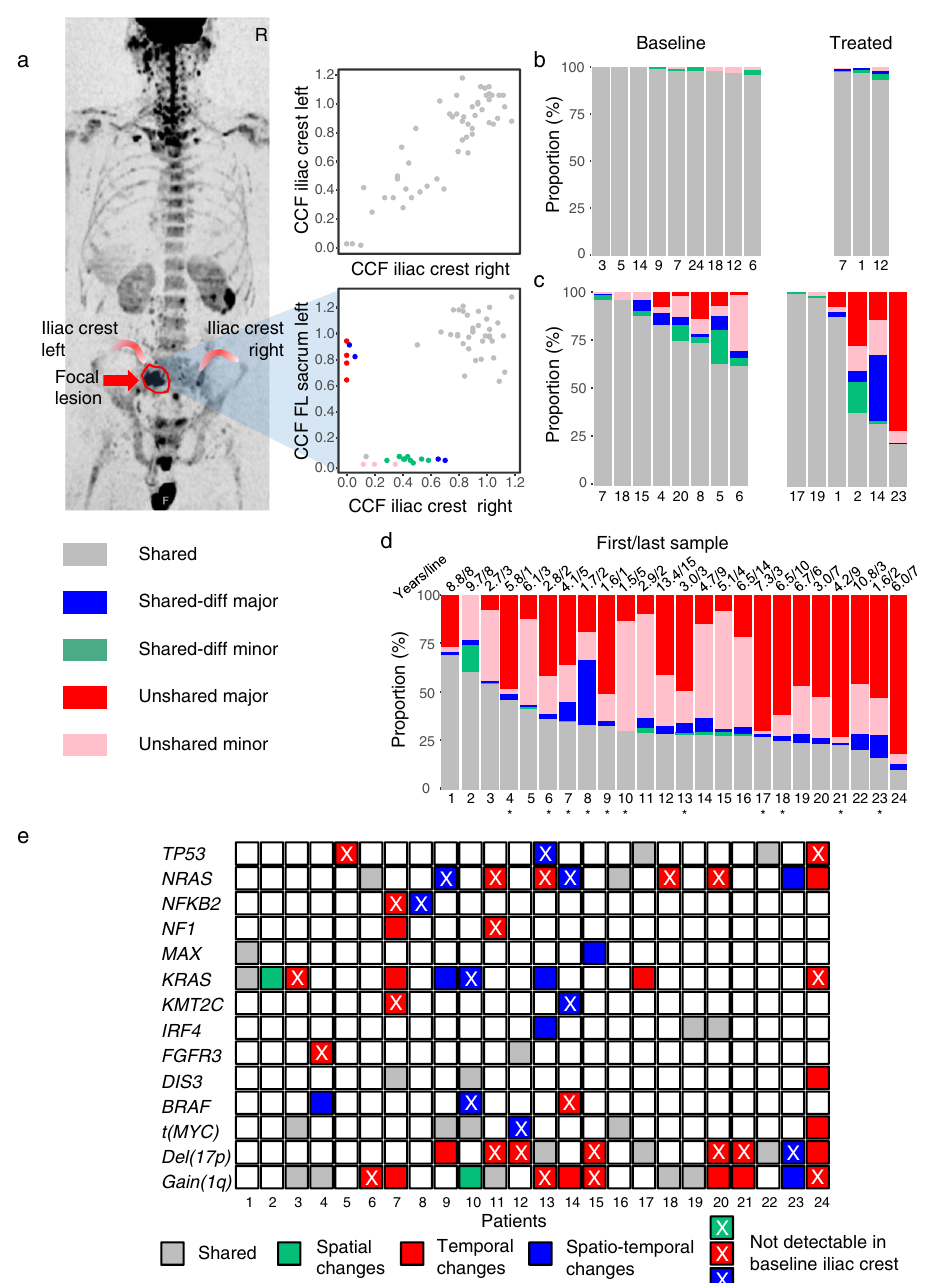
Fig.2|Spatialheterogeneityintimeandspace. Wecomparedmutationalpro fi les of paired samples collected from different bone marrow sites at baseline and duringtreatment,anddiscriminatedbetweenrandomlycollectedsamplesfromthe iliac crest and CT-guidedspecimens from focal lesions. In a the functionalimaging and the corresponding cancer clonal fraction (CCF) plots for detected mutations for patient #5 with paired samples from the right and left iliac crest as well as a sample from a left sacrum focal lesion are shown. In b , c the proportion of shared and heterogeneous mutations in paired left/right iliac crest and paired iliac crest/ focal lesion samples collected at baseline and within the same treatment line is presented, respectively. For this comparison, paired samples from patients #10, #13, #16, and #23 (baseline) as well as #9, #12, #22, and #24 (treated) were not considered, as they had already been included in our previous analysis of spatial heterogeneity 11 .In d themutationalpro fi lesofthe fi rstandthelastavailablesample per patient are compared. For patients, where an iliac crest sample was compared